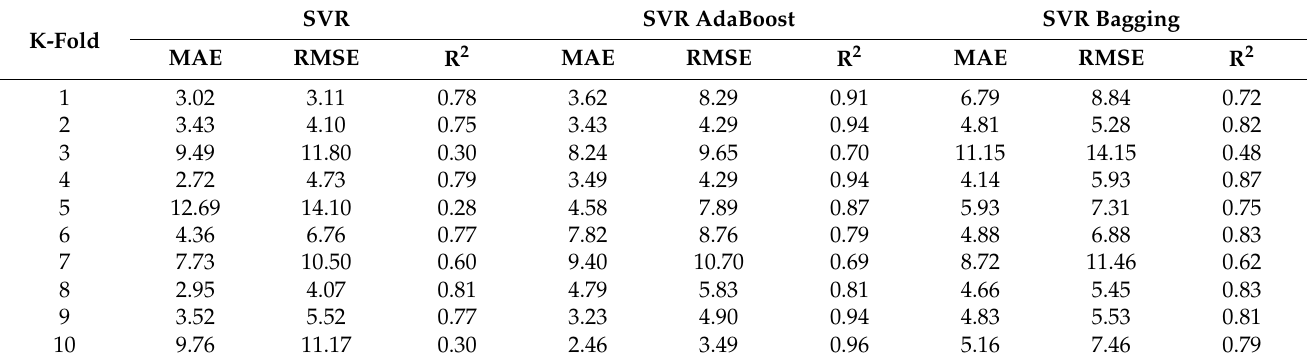
Figure 11. K-fold cross-validation representation for bagging model. Table 3. K-fold cross-validation